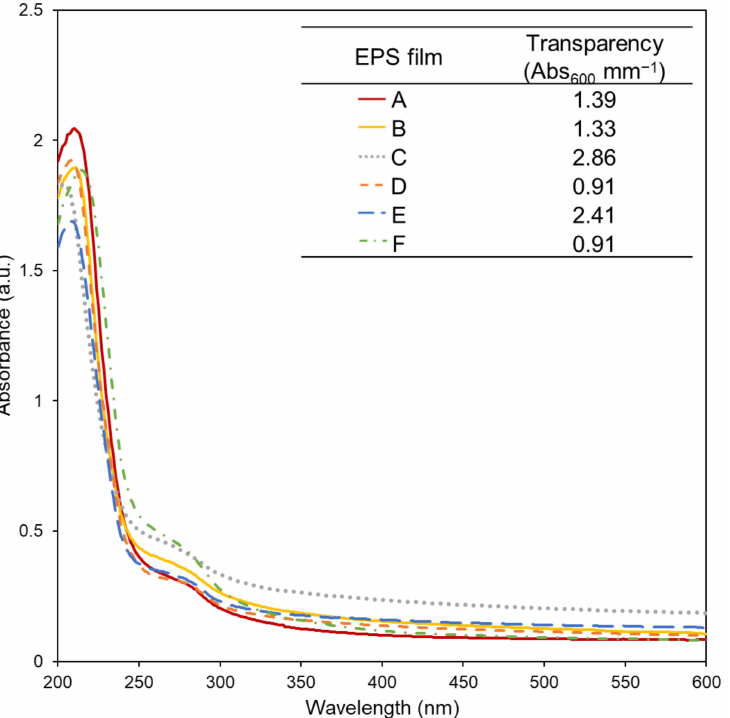
Figure 3. UV–vis absorption spectra and transparency (insert) of the films prepared with EPSs ( A – F ) produced by Alteromonas strains isolated from French